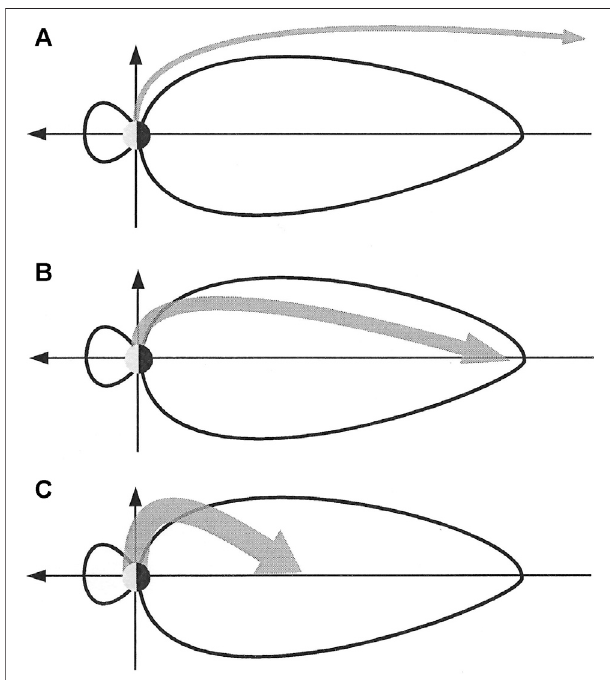
FIGURE 8 | The paths of the out fl owing polar wind as measured on the Cluster spacecraft showing the in fl uence of the solar wind Bz.